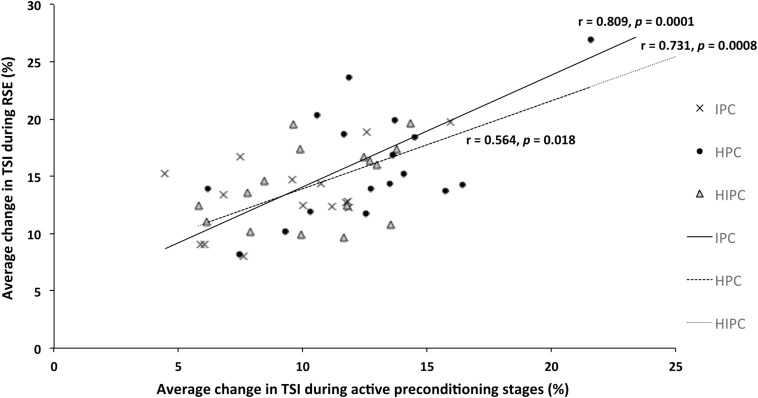
Representation of the relationship between average change (min–max) in tissue saturation index (TSI) amplitude post active phase during four active preconditioning stages and average changes (min–max) of TSI during repeated cycling sprint exercise following each treatment either with partial blood flow restriction (IPC); hypoxia exposure (HPC) or combined hypoxia with partial blood flow restriction (HIPC).